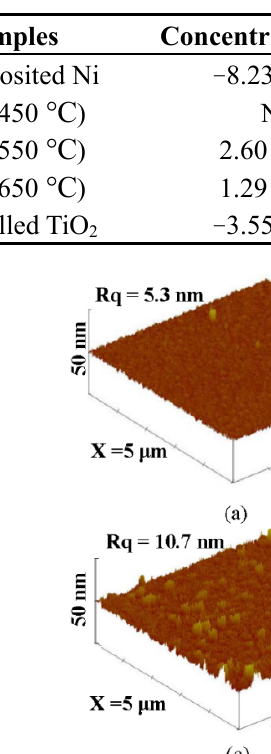
Table 2. Electrical properties of the as-deposited Ni film, the controlled TiO 2 film, and the films annealed at temperatures of 450 °C, 550 °C and 650 °C, respectively.